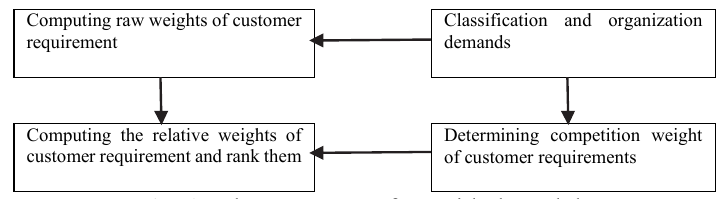
Fig. 2. The structure of provided